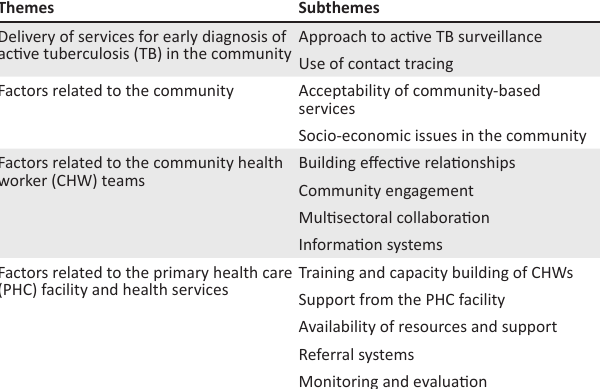
TABLE 2: List of themes and